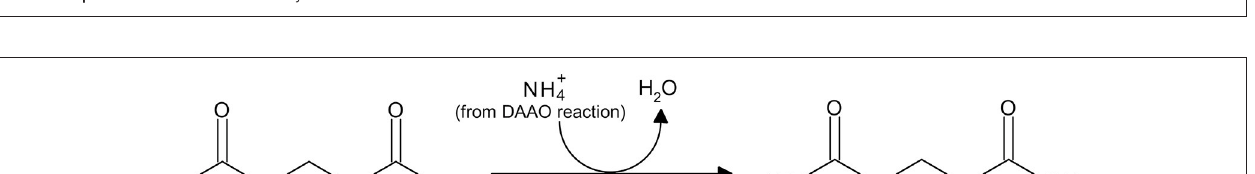
FIGURE 4 | Detection of α -keto acids by derivatization with DNP.